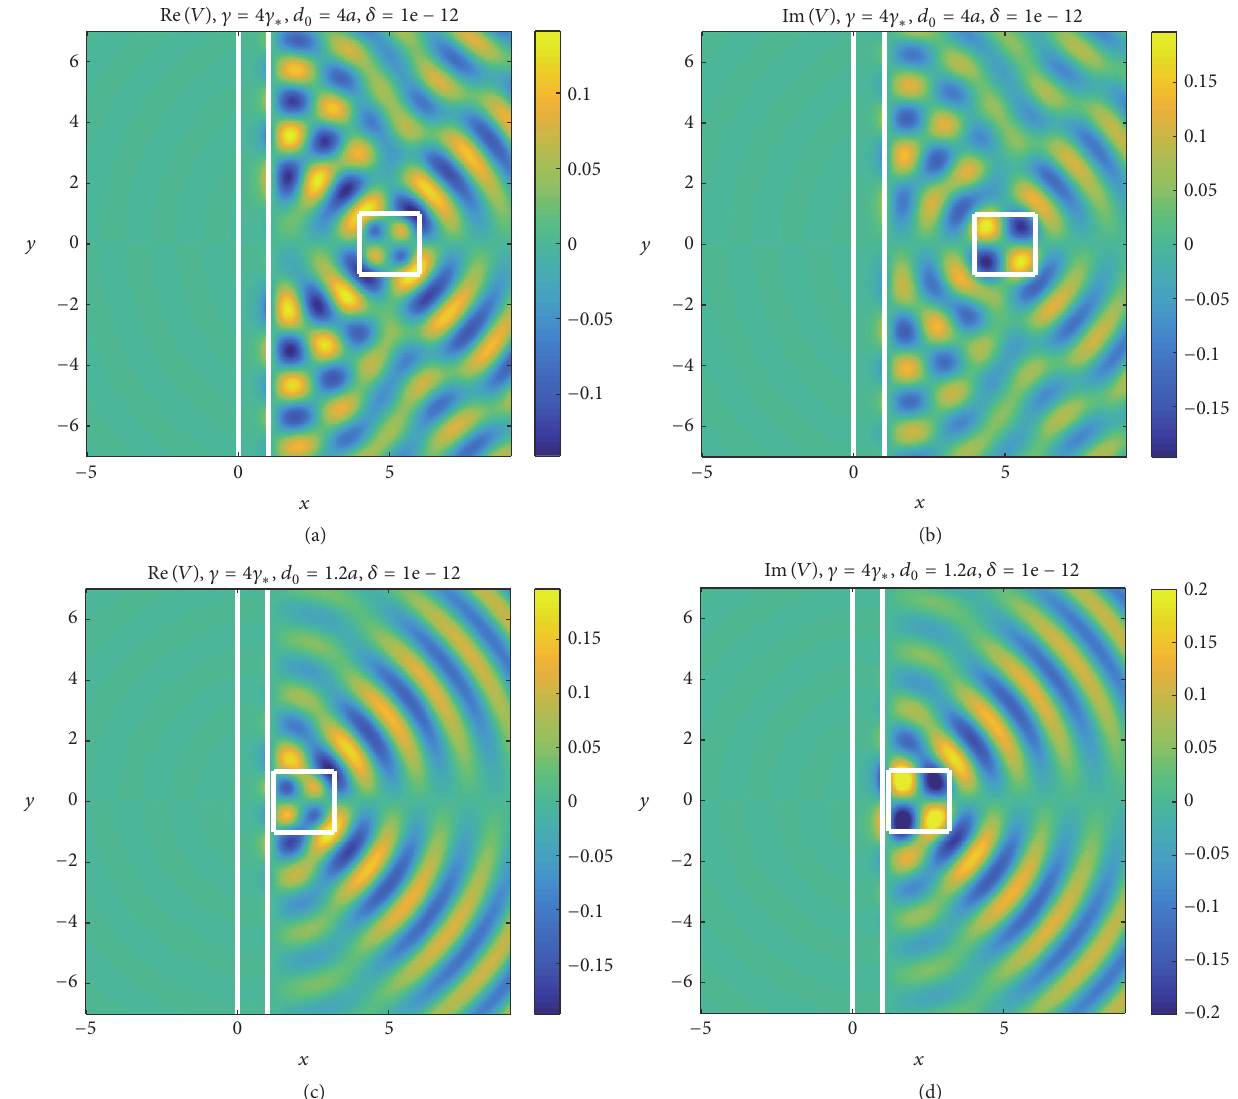
Figure 4: This is a plot of 𝑉 , the solution to (4), when 𝑓 is the function in (49) and 𝛾 = 2𝛾 ∗ : (a) Re (𝑉) and (b) Im (𝑉) for 𝑑 0 = 4𝑎 ; (c) Re (𝑉) and (d) Im (𝑉) for 𝑑 0 = 1.2𝑎 . To make the behavior of 𝑉 clearer, we clipped the maximum and minimum values in each plot to 0.2 (yellow) and −0.2 (blue),